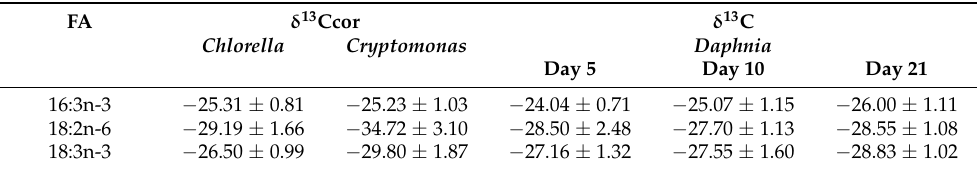
Table 3. Input data for IsoError mixing model: corrected average isotope values δ 13 Ccor (‰, ± SD) for algae and isotope values δ 13 C for Daphnia .